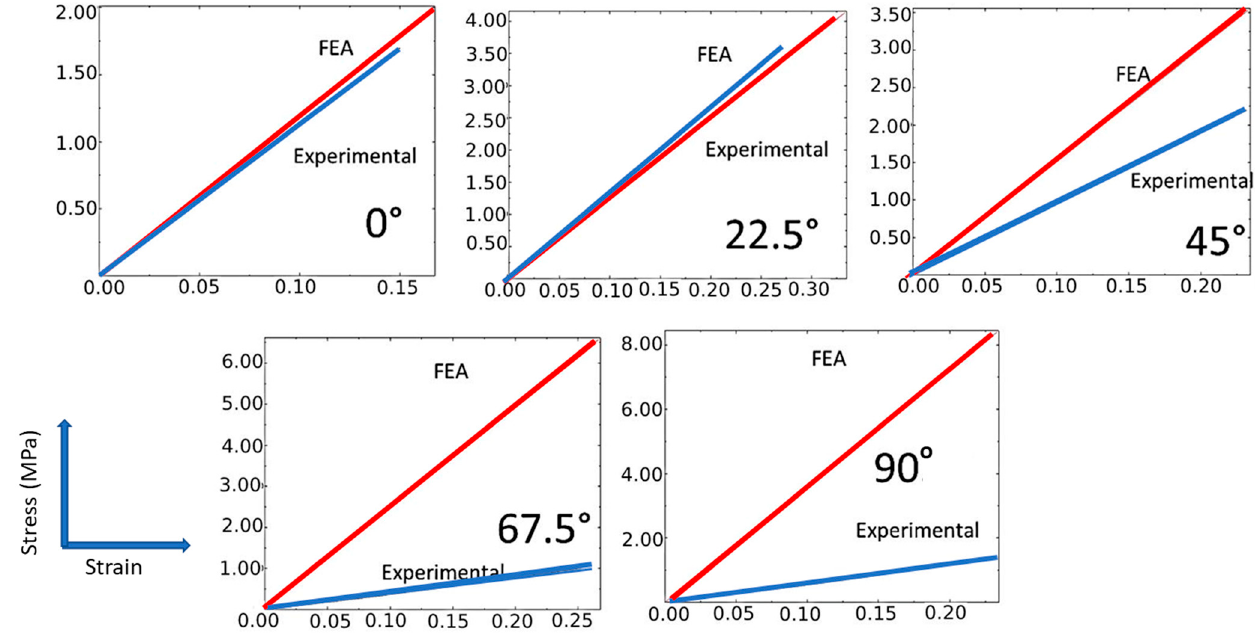
Figure 5. Stress–strain response of nylon/Kevlar fiber composites with different orientations.